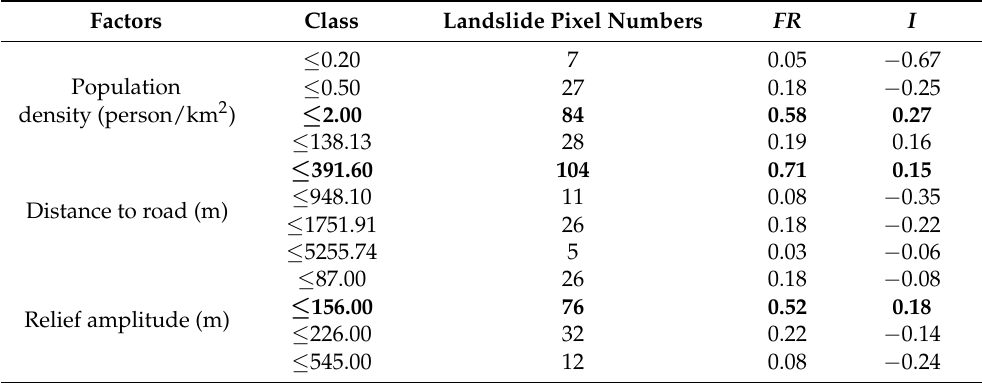
Table 8. Application of information quality (I) and frequency ratio (FR) to show the relationship between key factors and landslide risk occurrence. Note: bold numbers indicate the most influential